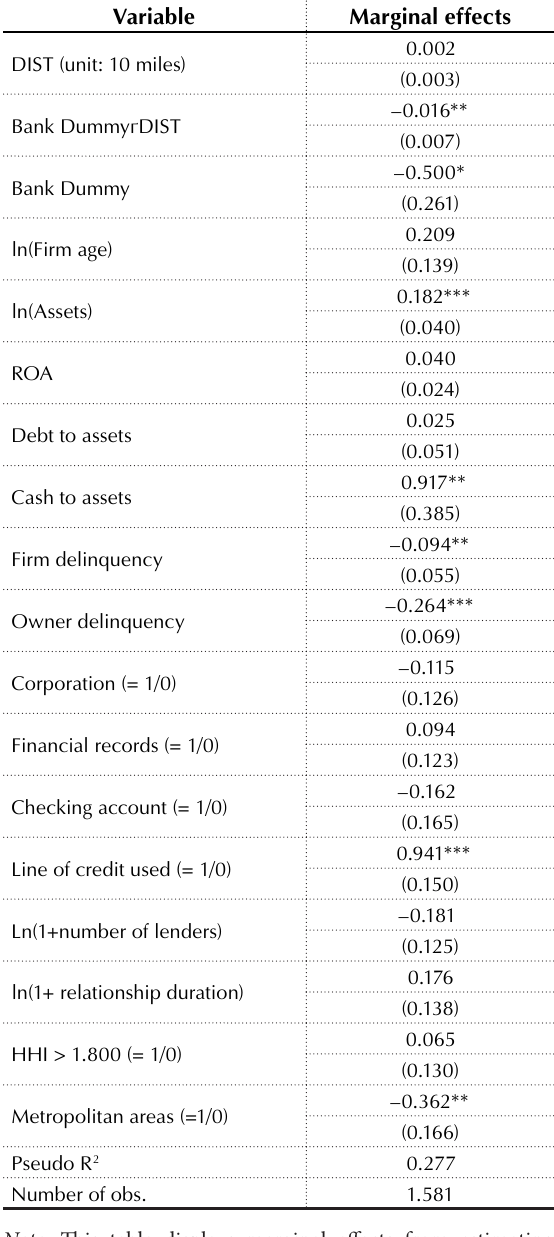
Table 2. Distance to borrowers and credit